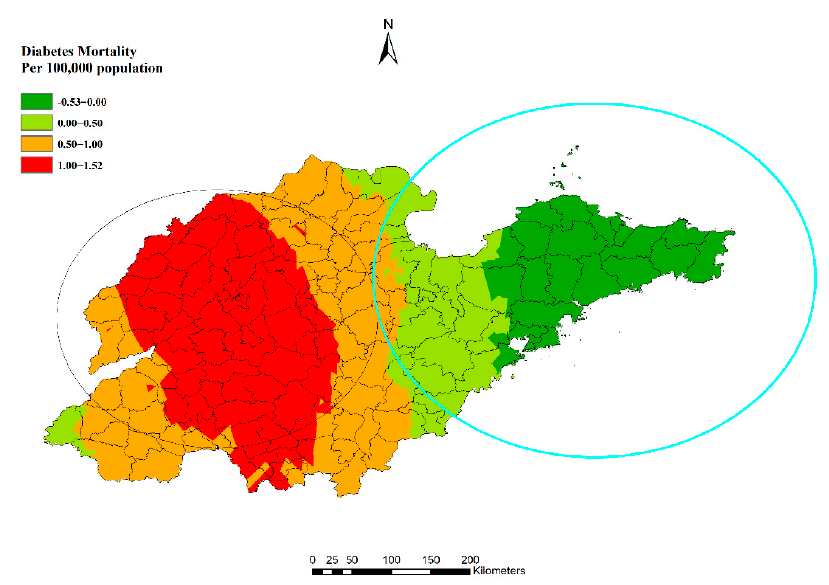
Figure 8. Differences in diabetes mortality between winter and summer in men.